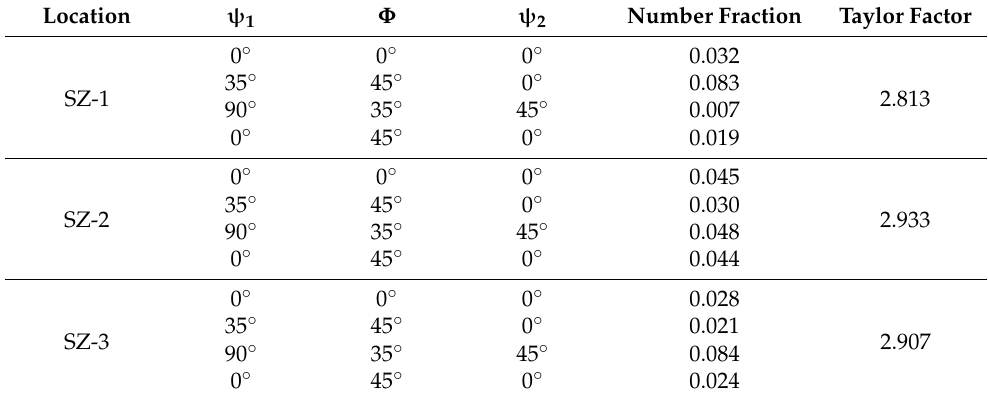
Table 2. Taylor factor and main texture types and contents contained in SZ-1, SZ-2 and